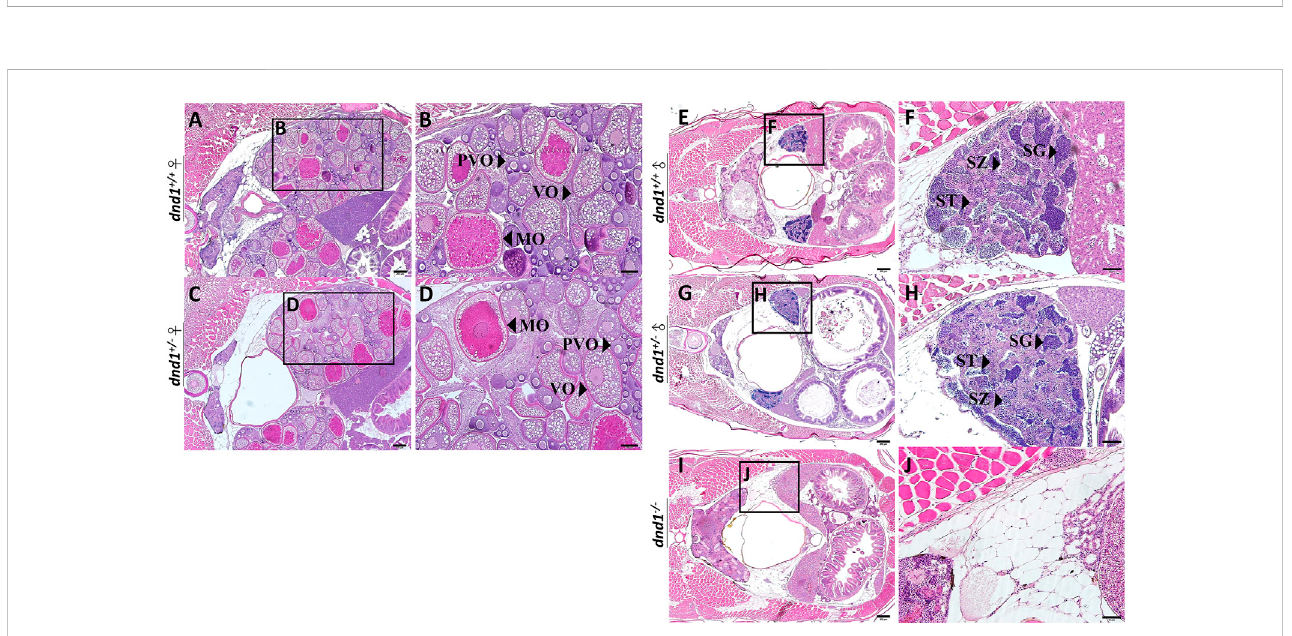
FIGURE 3 ddx4 expression visualized by whole-mount in situ hybridization in 24-h post-fertilized embryos of the F embryo. (C) - (D) Mutant zebra fi sh embryo. Bars = 200 μ m (A, C) and 100 μ m (B, D) .